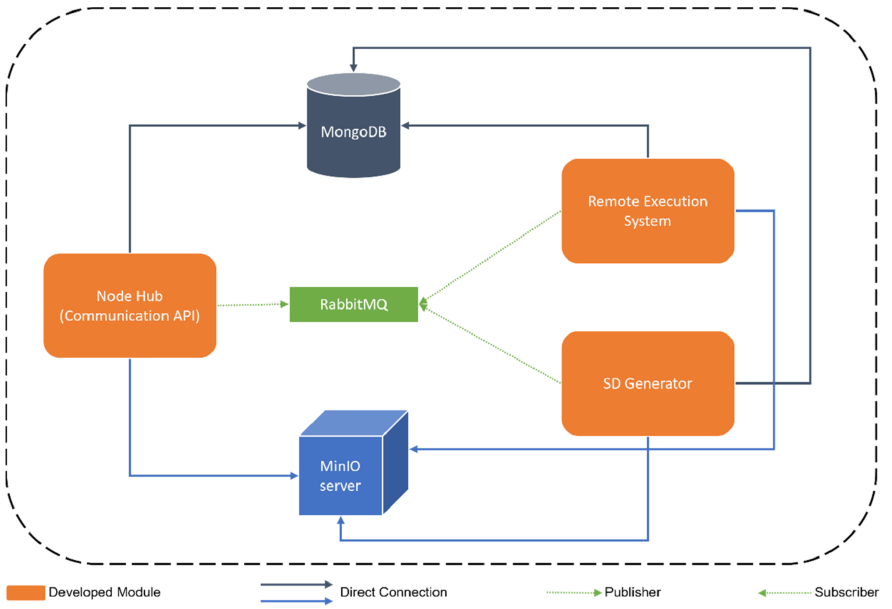
Figure 2. Components of the VITALISE Node